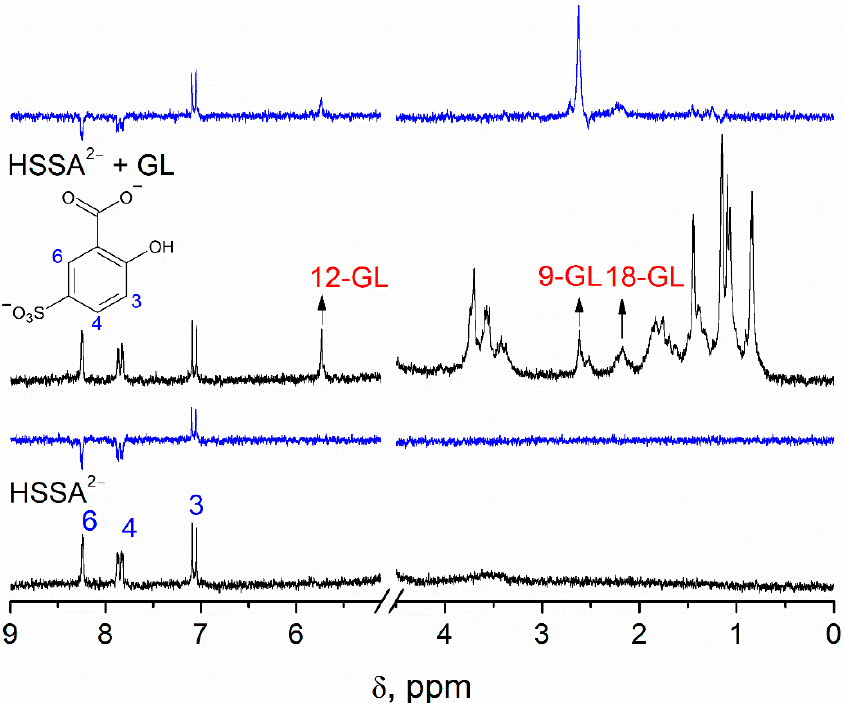
Figure 5. 1 H NMR and TR ‐ CIDNP (blue) spectra of 1 mM HSSA 2 − in water (pH = 10) and 1 mM HSSA 2 − and 1.5 mM GL in water (pH = 10). The delay time between the laser pulse and NMR detection pulse is 50 μ s for both cases.